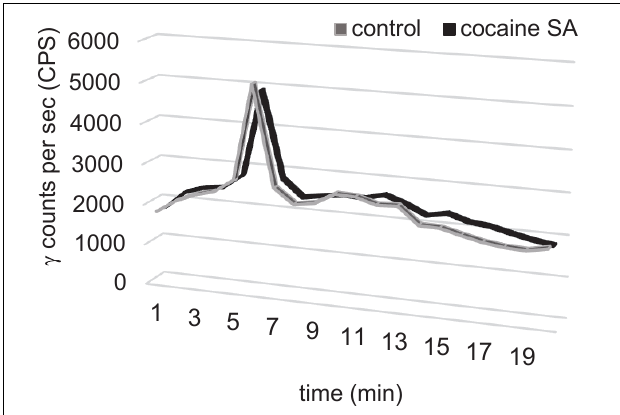
FIGURE 4 | Representative HPLC plasma metabolite results of [ 11 C]MPC-6827 in a control and cocaine SA rat demonstrating a major peak